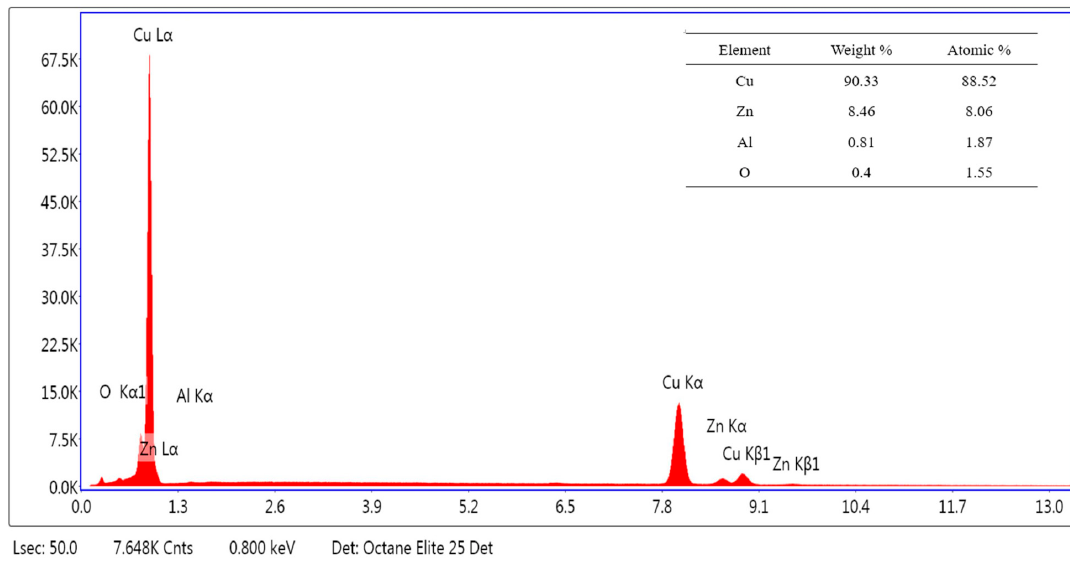
Figure 4. Elemental analysis of micrometer copper ‐ zinc alloy particles.